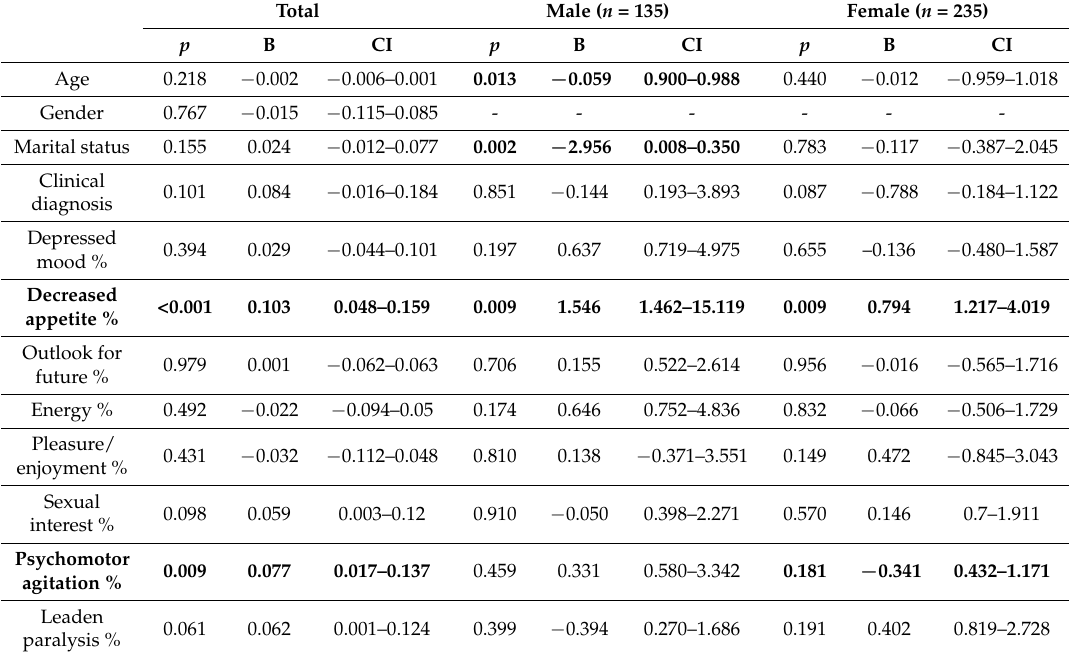
Table 4. Multivariate analysis: logistic regression, with sleep disturbance as the dependent binary variable, in AD and DE combined (i.e., the entire